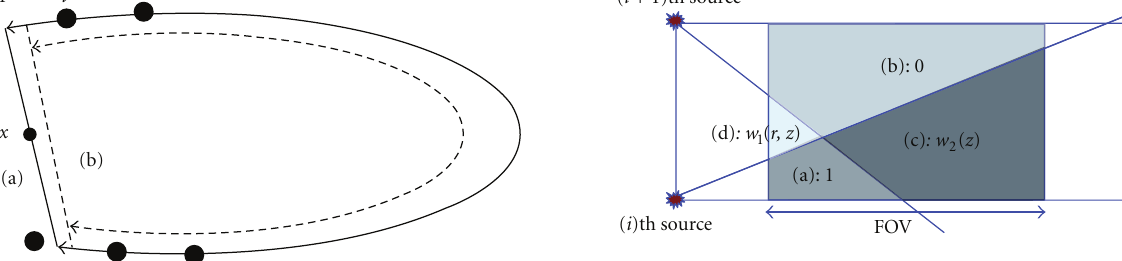
shown in solid line with bidirectional arrow. The end points of the pi-line are closer to the pair of source samples just outside the pi-segment (i.e., ( i − 1) and ( j + 1)) than they are to the pair just inside the pi-segment (i.e., ( i ) and ( j )). view samples at ( i − 1) and ( j +1) completely. This e ff ectively approximates the pi-line as being the dashed line in Figure 7, and the corresponding pi-segment is shown in a dashed line with bidirectional arrow.